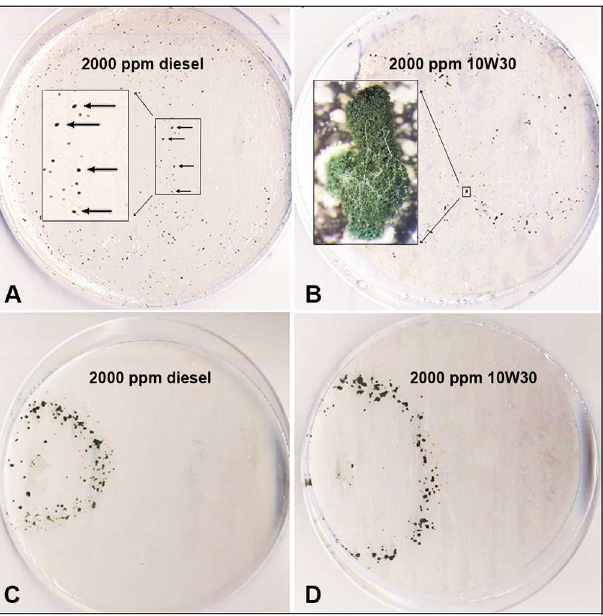
Fig 5. Trichoderma harzianum TSTh20-1 (TSTh) growing for 14 d (A, B) or 7 d (C, D) on diesel and 10W30 oil, respectively. TSTh in A, B had been growingfor 5 weeks on petrochemicals, whereasC, D had been growingfor 16 weeks. Box in A indicates tiny spore aggregates(ca 10 5 spores) on diesel. Box in B indicatesa larger spore aggregate(ca 5x10 6 ) on 10W30. Growth and sporulation was much improved in Fig 5C, D.